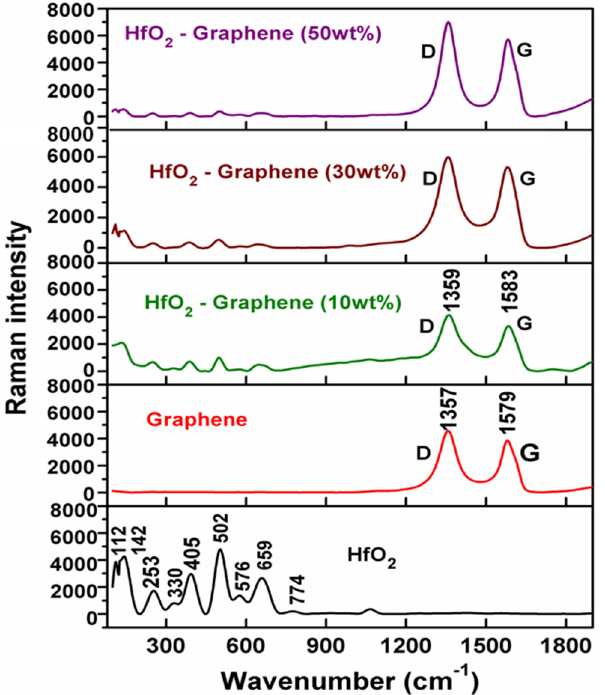
Figure 2. Raman spectra of HfO 2 nanoparticles, graphene, HfO 2 -graphene (10, 30, and 50 wt%) nano-